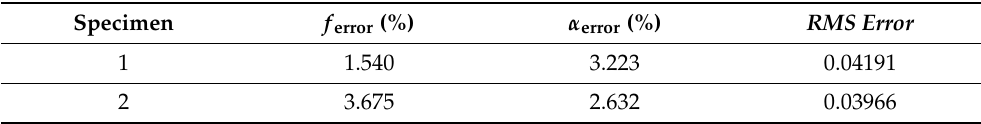
Table 2. Mean values of the error indices for the four conditions of air-back cavity depth of specimens 1 and